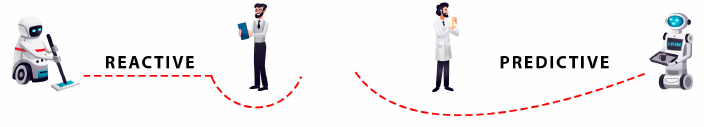
Figure 13. Navigation methods for robot social